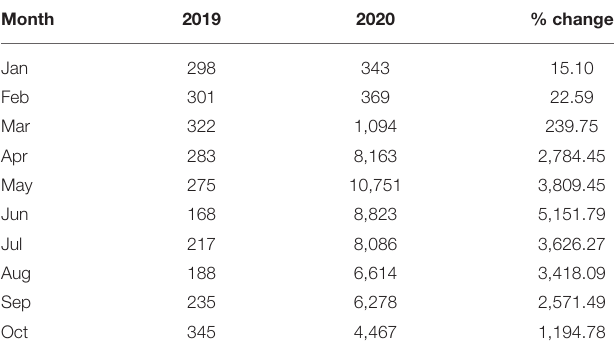
TABLE 3 | Telehealth visit counts in 2019 vs.